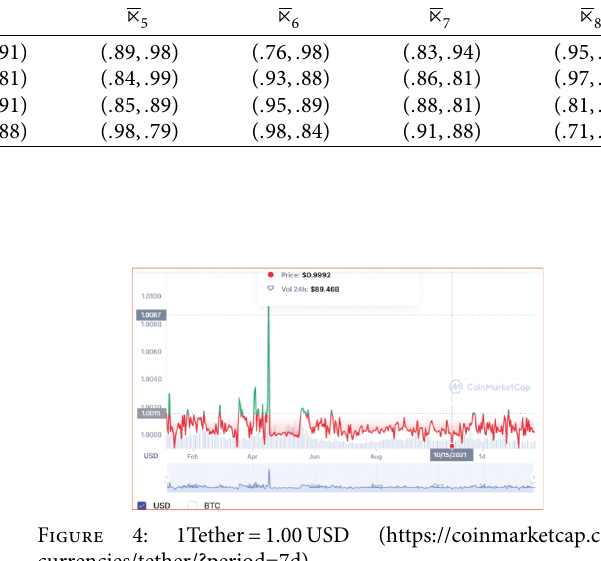
Figure 2: 1ETH � 3760.10USD (source: price index data from CoinDesk (https://coinmarketcap.com/currencies/ethereum/? period � 7d)).